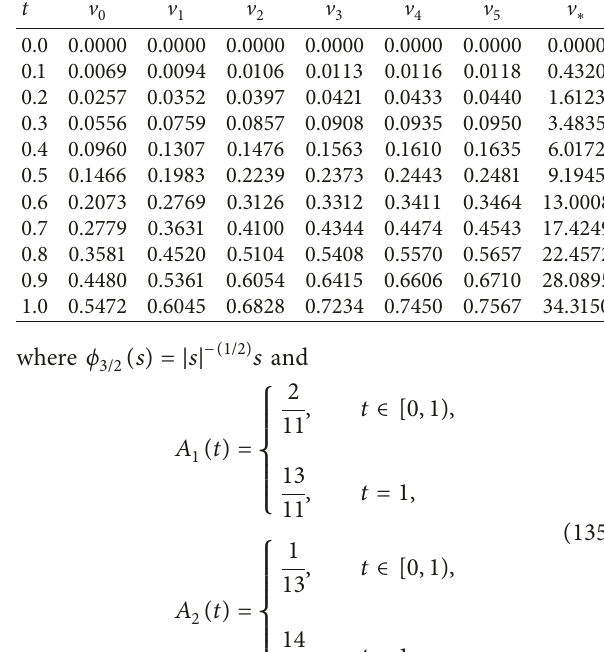
􏽥 v i and i . Table 1: Iterative process of v